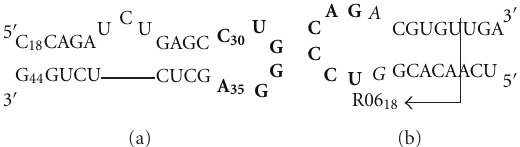
Figure 1: Sequence and secondary structure of (a) HIV-1 mini-TAR RNA, (b) R06 24 and R06 18 aptamers reported in this study. Bold bases indicate complementarity between aptamer and TAR loops. The crucial G and A residues flanking the R06 aptamers loop are in italics.